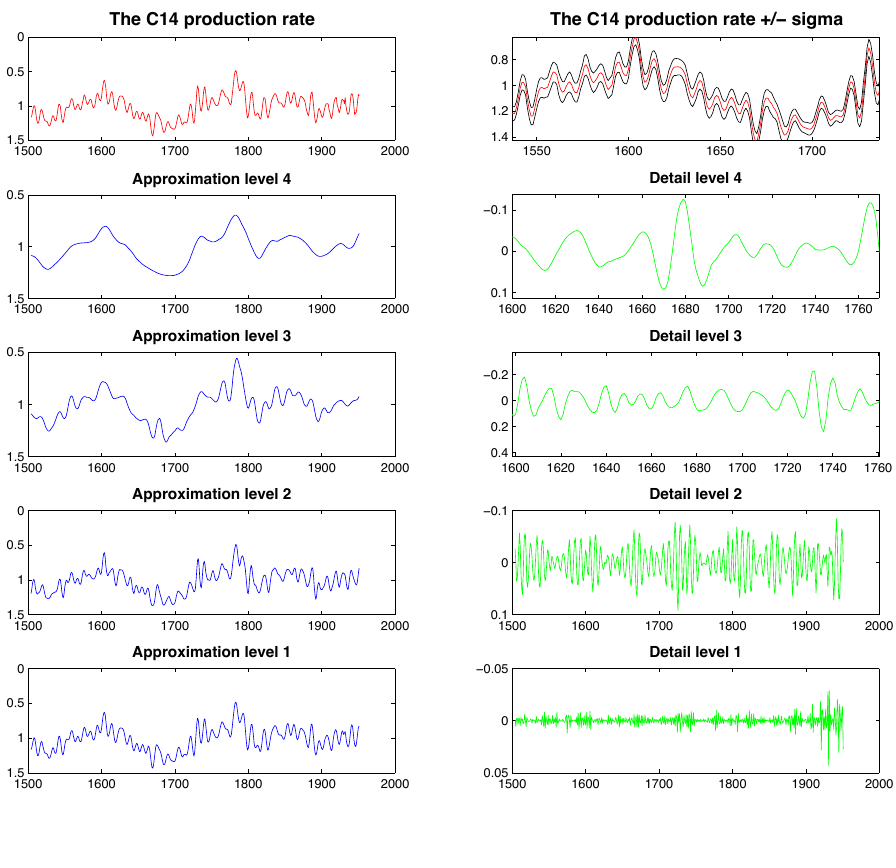
Fig. 5. Multi-resolution analysis of the 14 C production rate. The 22-year cycle is clearly present during the Maunder Minimum (zoomed in period) at detail level 4. The 11-year cycle is clearly present during the Maunder Minimum (zoomed in period) at detail level